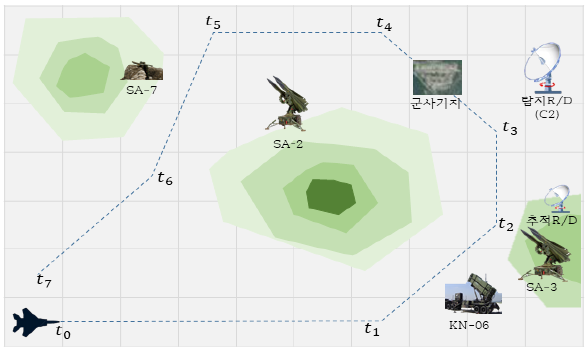
Figure 19. Flight path of a UAS in aerial EW (Electronic Warfare) simulation.